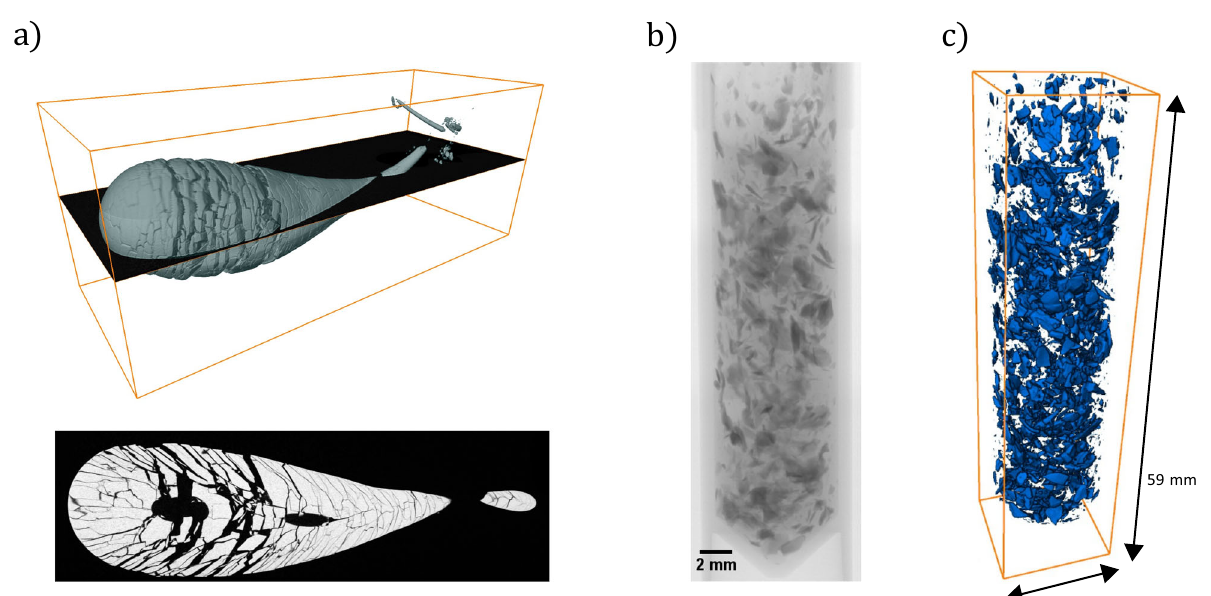
Fig. 2 Prince Rupert ’ s drops fragmented inside a Carbopol matrix. a 3D reconstruction based on micro-computed tomography (micro-CT) data (top); cross-section as indicated by the black plane in the 3D image (bottom). There does not appear to be any clear spatial distribution of fragment sizes (see also Supplementary Information), except the arrangement of particles seems to have a structure similar to a pine cone. b X-ray image of some of the fragments inside the Carbopol matrix. c Example of a full 3D reconstruction used to determine individual fragment